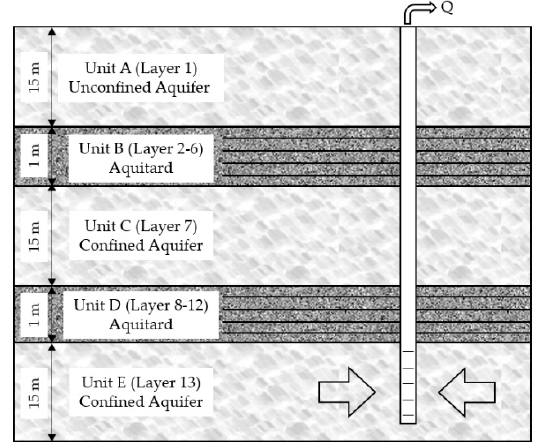
Figure 5. Conceptual model including a five-layer aquifer system comprising three aquifers and two aquitards, as well as a pumping well fully penetrating the third aquifer. Table 1. Hydrogeological and mechanical properties of the model.